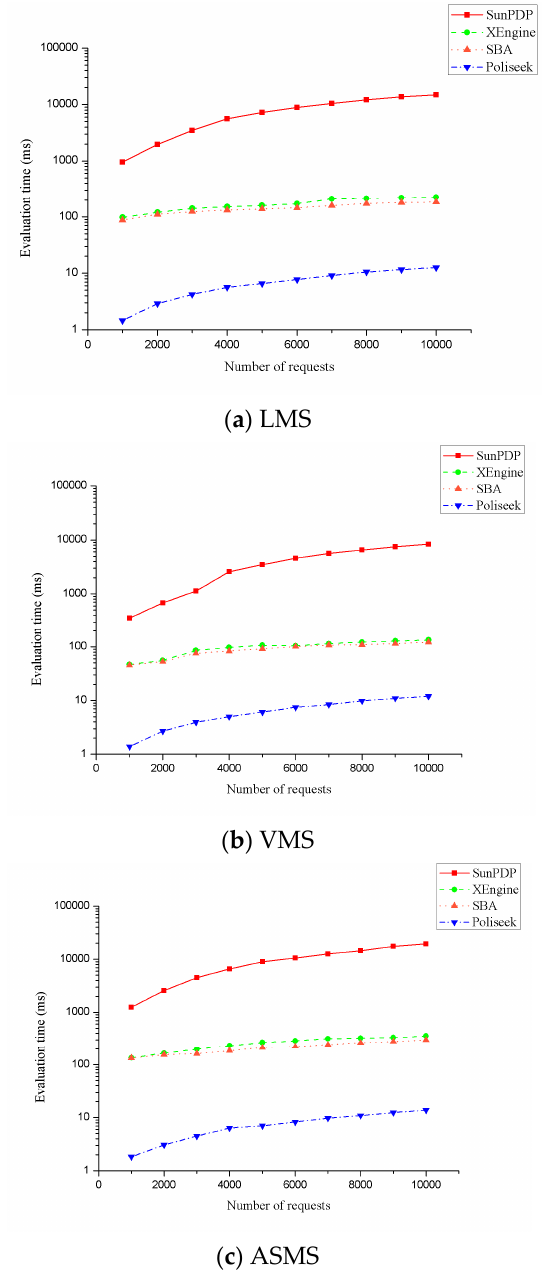
Figure 8. Evaluation performance and comparison of different schemes in LMS, VMS, and ASMS.